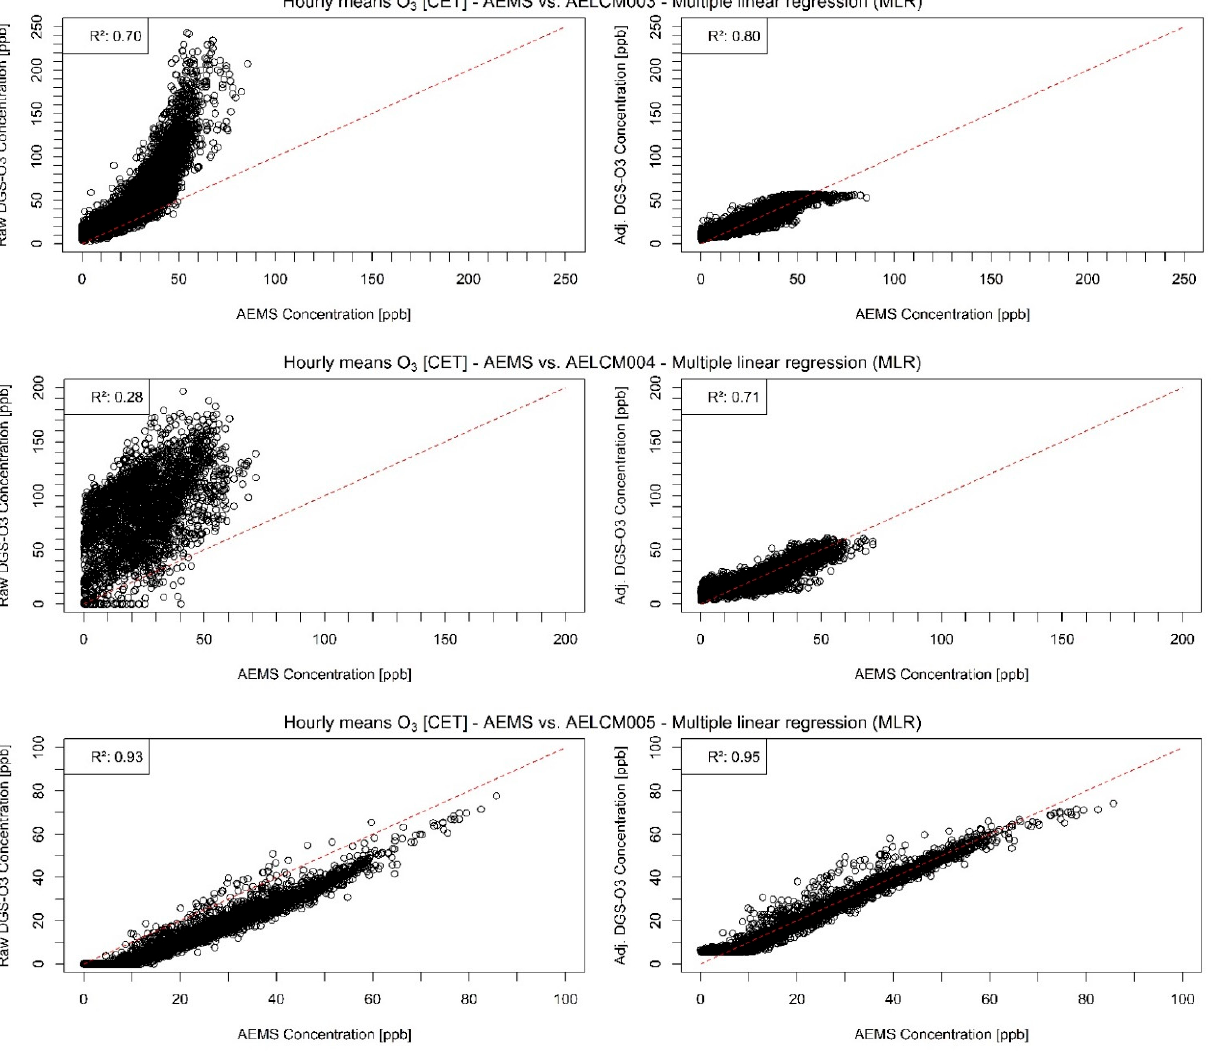
Figure 3. Raw ( left ) and model-adjusted ( right ) hourly concentration means of different deployed SPEC DGS-O3 vs. hourly concentration means of reference measurements given by the AEMS for ambient O 3 in ppb: ( Top ) SPEC DGS-O3 deployed in AELCM003; ( Middle ) SPEC DGS-O3 deployed in AELCM004; and ( Bottom ) SPEC DGS-O3 deployed in AELCM005. Multiple linear regression is used for adjusting the raw LCS data.